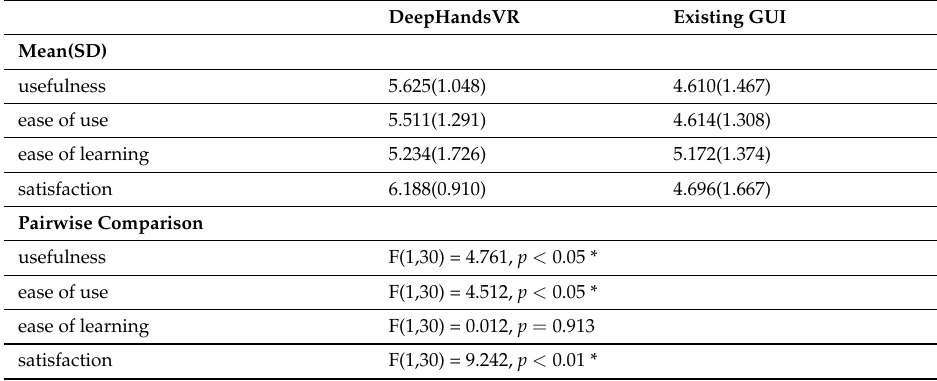
Table 1. Satisfaction analysis results of the proposed hand interface.